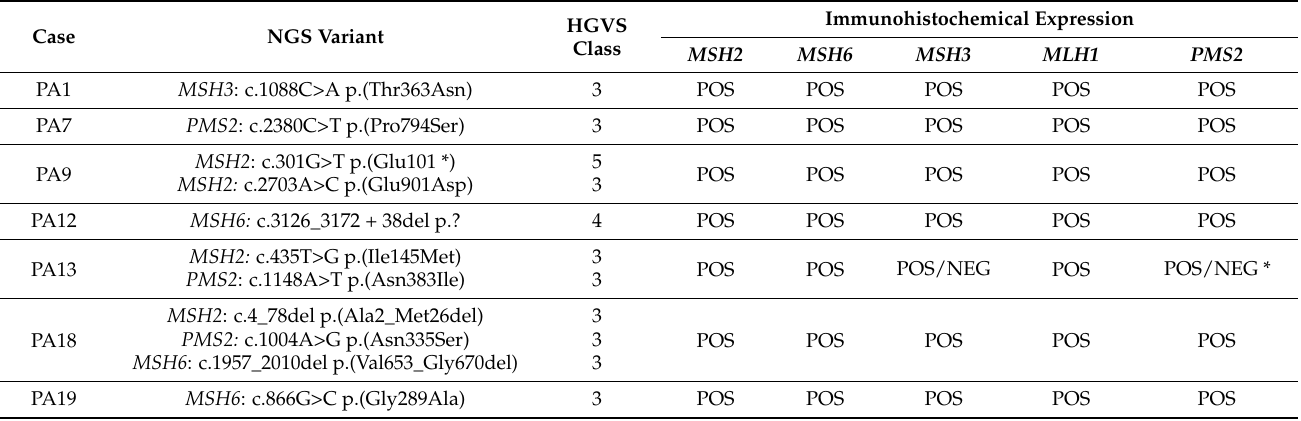
* Heterogeneous pattern of PMS2 expression (see Section